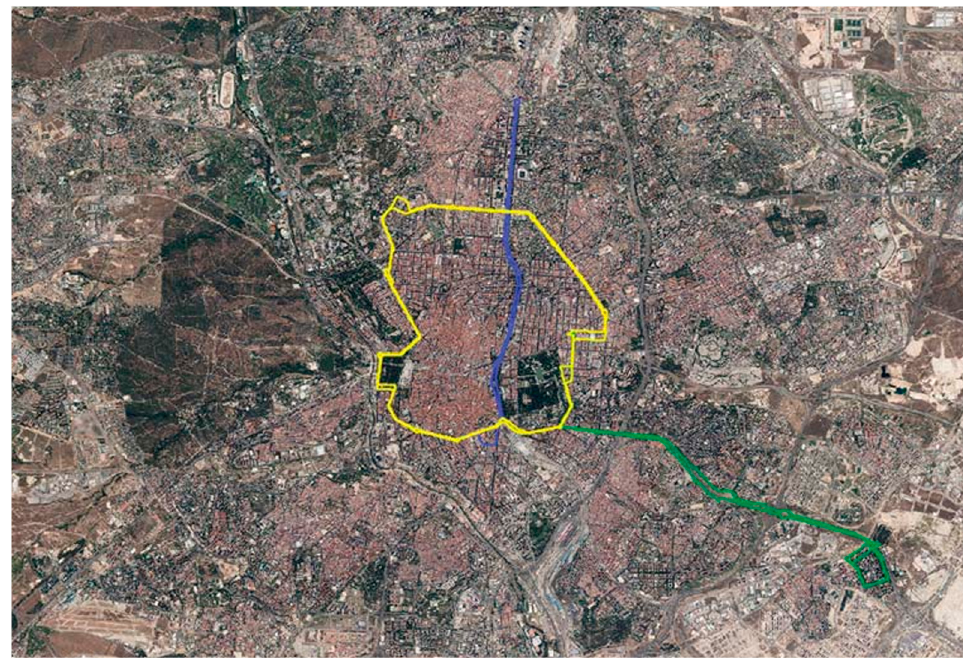
Figure 1. Urban lines: Circular C1 (yellow), Line 27 (blue), and Line 63 (green).